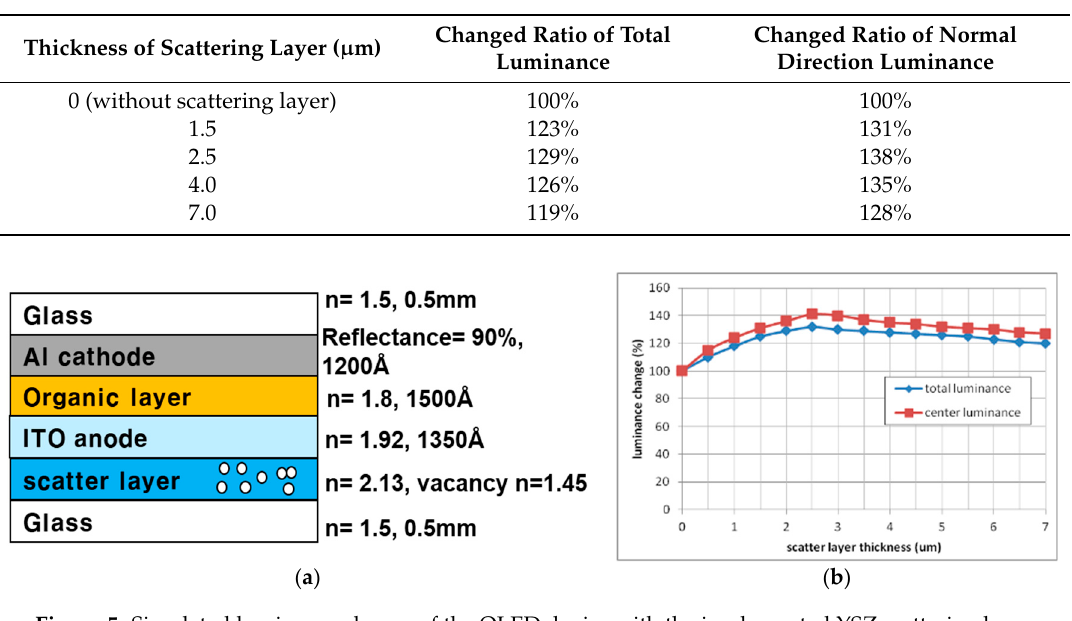
Figure 5. Simulated luminance change of the OLED device with the implemented YSZ scattering layer: ( a ) Schematic diagram and parameters of the OLED device; ( b ) Simulated total luminance and center luminance to normal direction as a function of the thickness of the scattering layer.